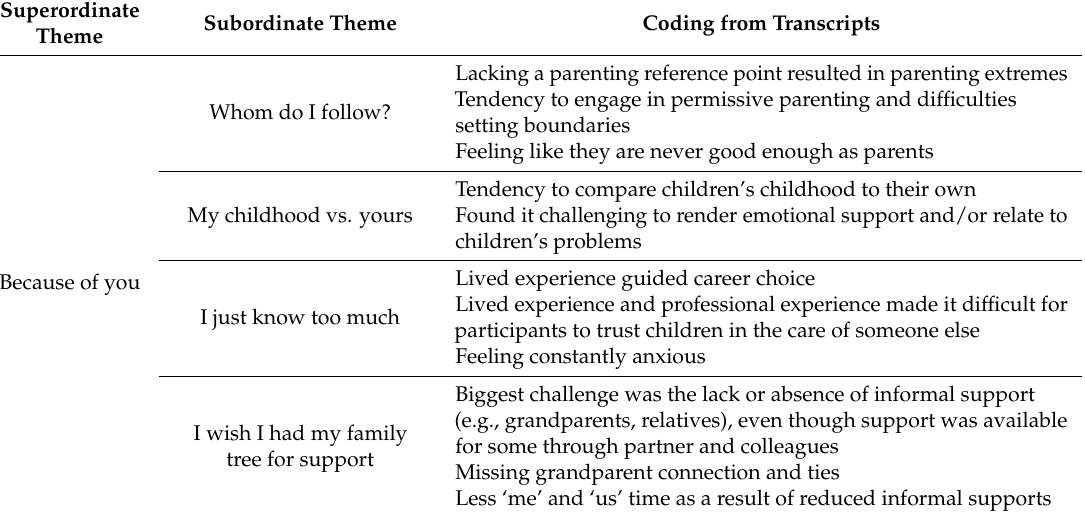
Table 4. Superordinate and subordinate themes for: ‘because of